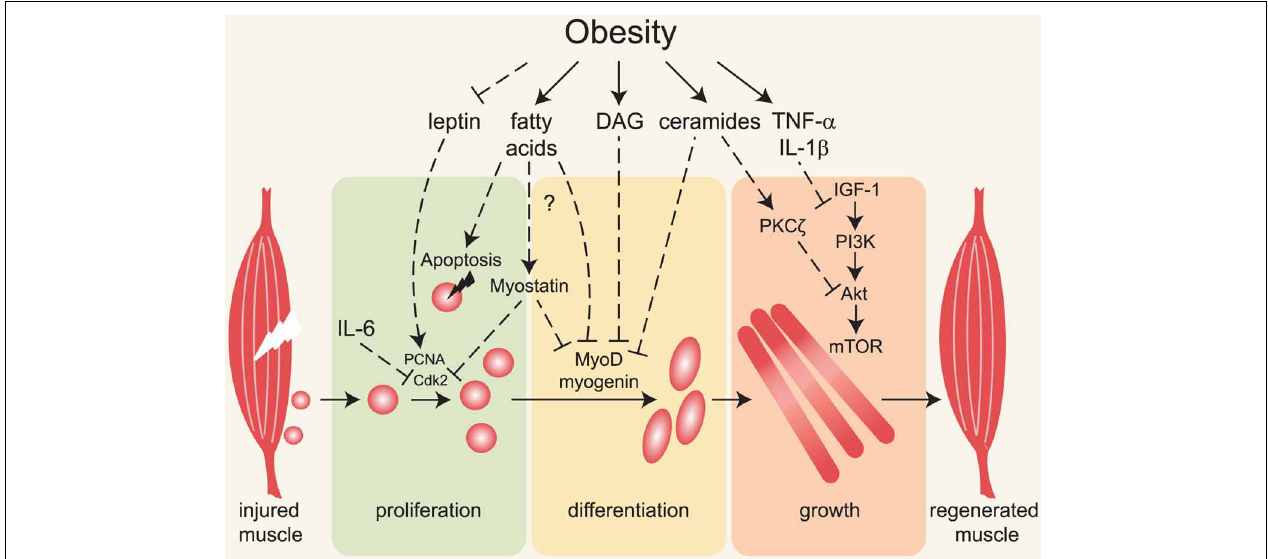
FIGURE 1 | Major mechanisms linking obesity with impaired muscle regeneration. Obesity is associated with insulin and leptin resistance, elevated circulating and intramuscular fatty acids, diacylglycerols, ceramides and pro-inflammatory cytokines. Following muscle injury, satellite cells (depicted adjacent to muscle on left) are activated, proliferate, differentiate and form myofibers that grow and replace damaged tissue. Impairment of these processes underlies inefficient muscle regeneration in obese rodents.